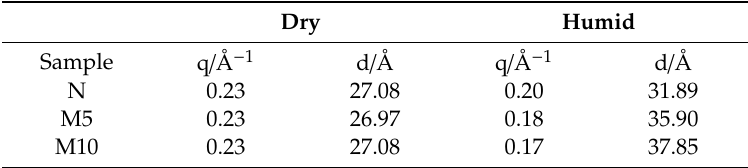
Table 2. Values of q and d estimated for all the samples at dry and humidified